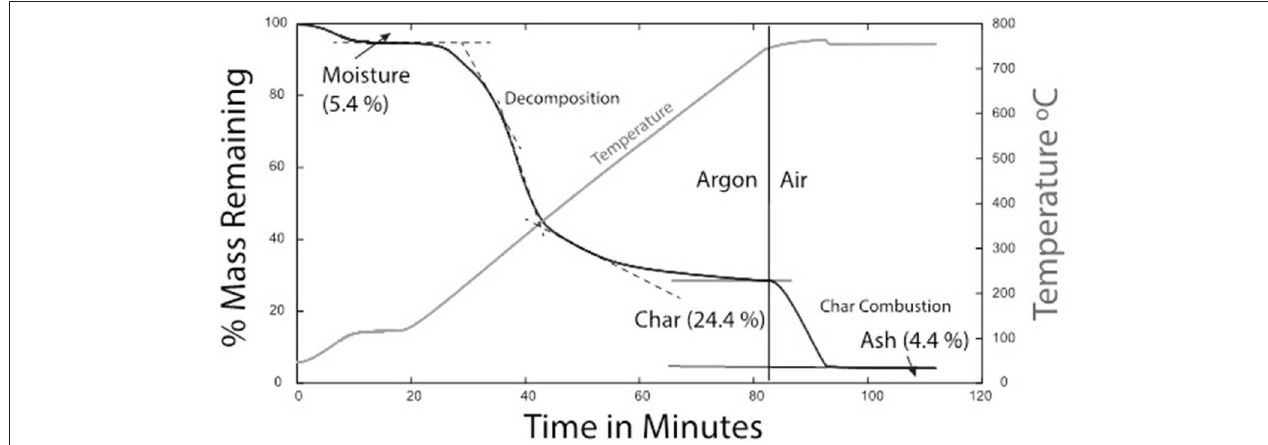
FIGURE 2 | Thermogravimetric analysis of almond shell feedstock [sample S3 of Aktas et al. (2015)]. Experiment done in an open alumina container using a principal ramp rate of 10 o C min − 1 and argon carrier gas to 750 o C followed by